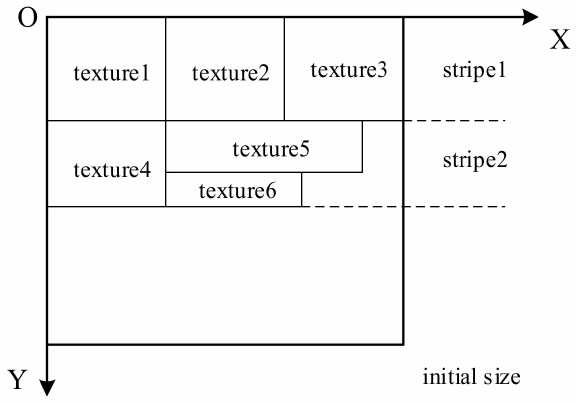
Figure 2. Multi-texture packing sketch